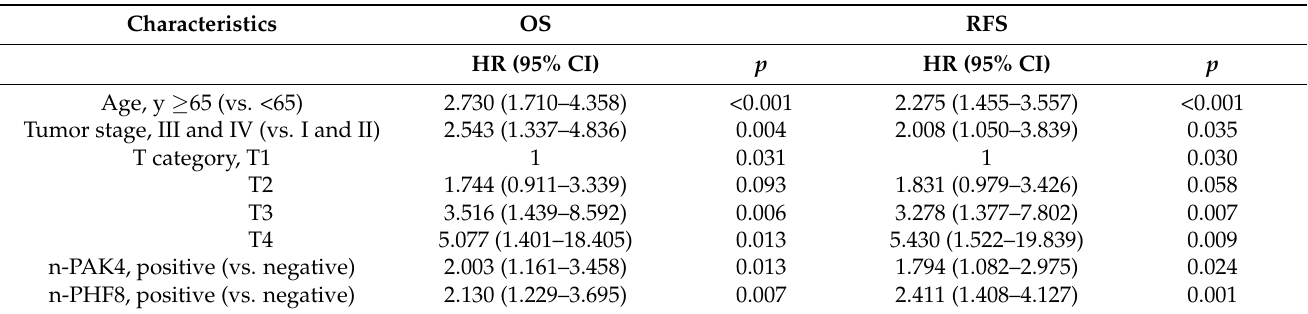
Table 3. Multivariate Cox regression analysis in